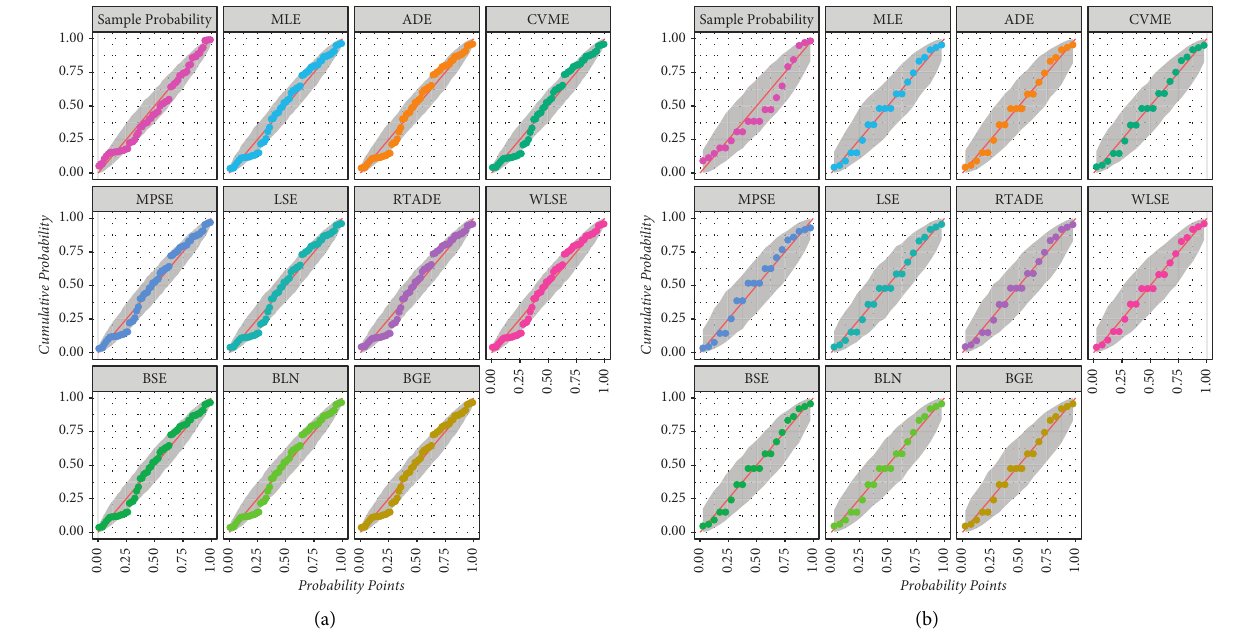
Figure 6: P-P plots of the IPBH distribution using several estimation approaches for dataset I (a) and dataset II